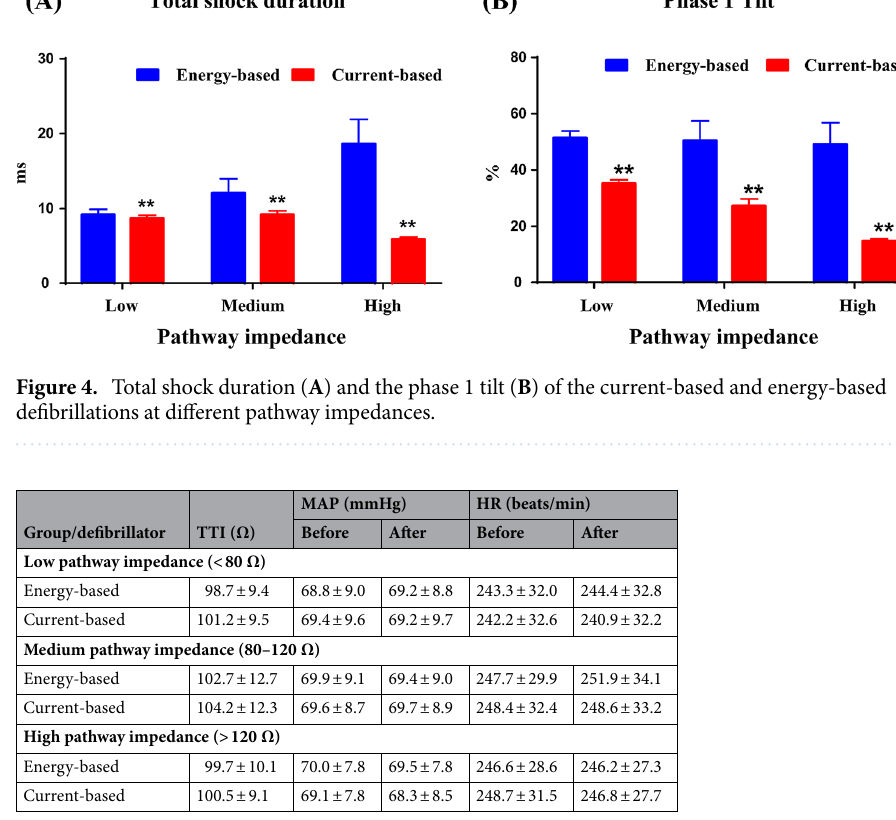
Table 1. Haemodynamic data measurements at each fibrillation/defibrillation event for different pathway impedances.